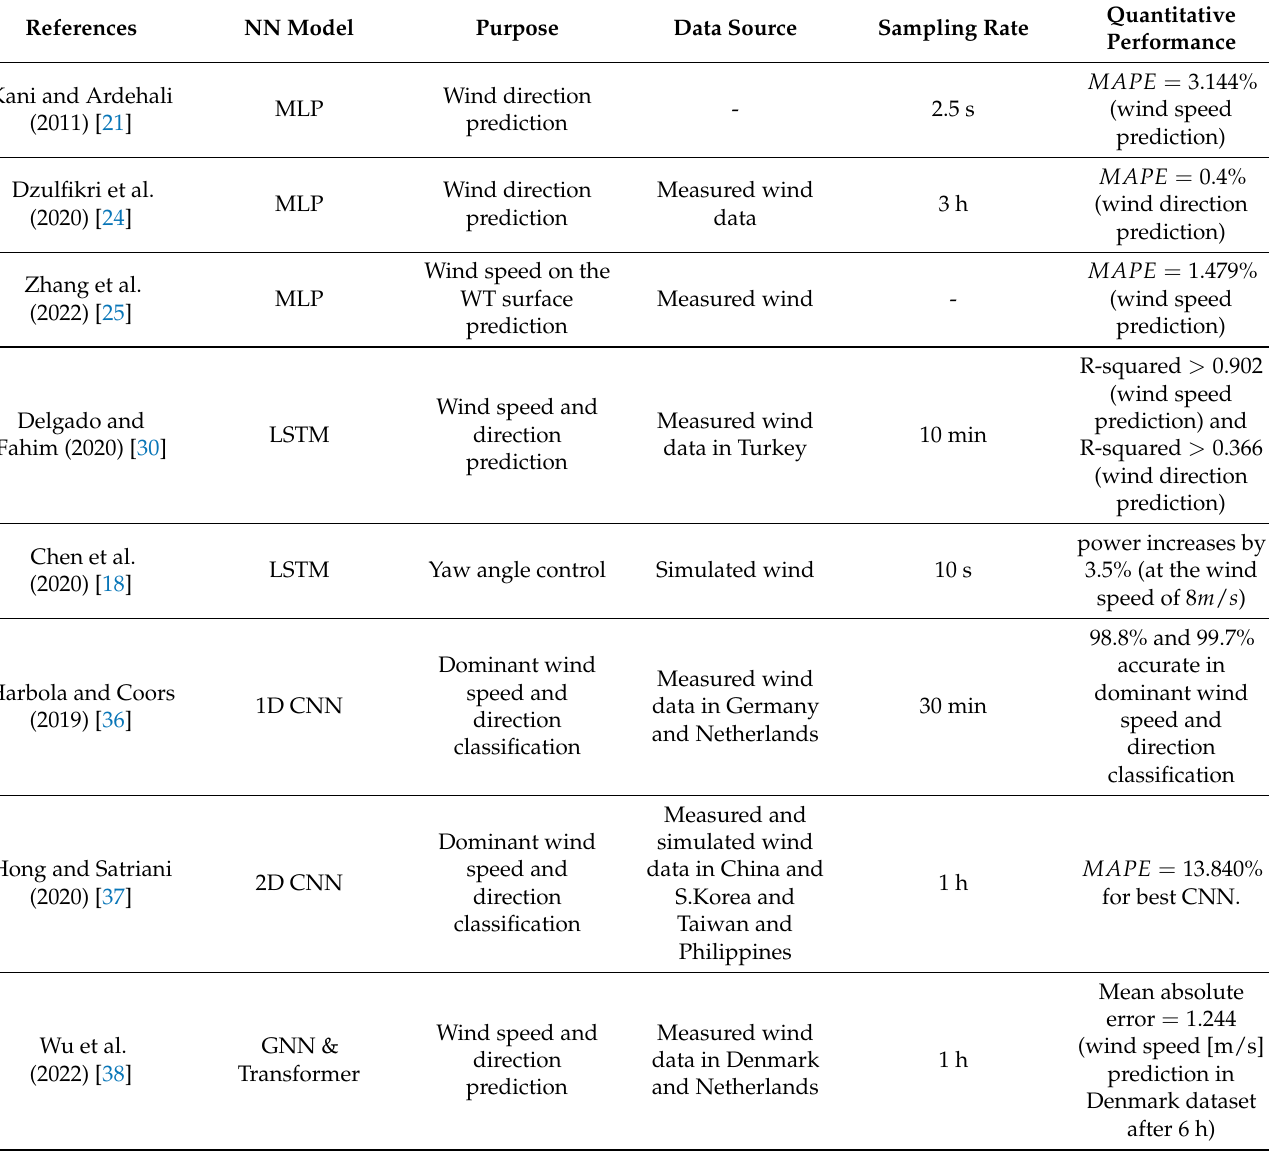
Table 1. NN-based wind prediction and single WT control